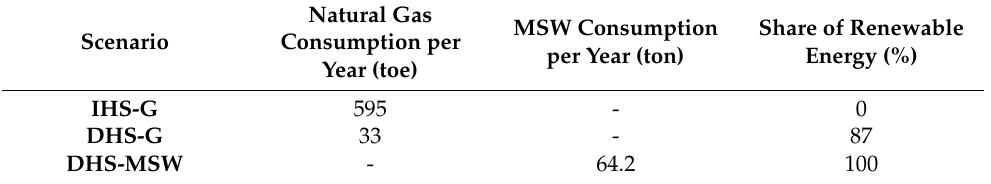
Table 13. Natural gas and MSW consumption in proposed scenarios.